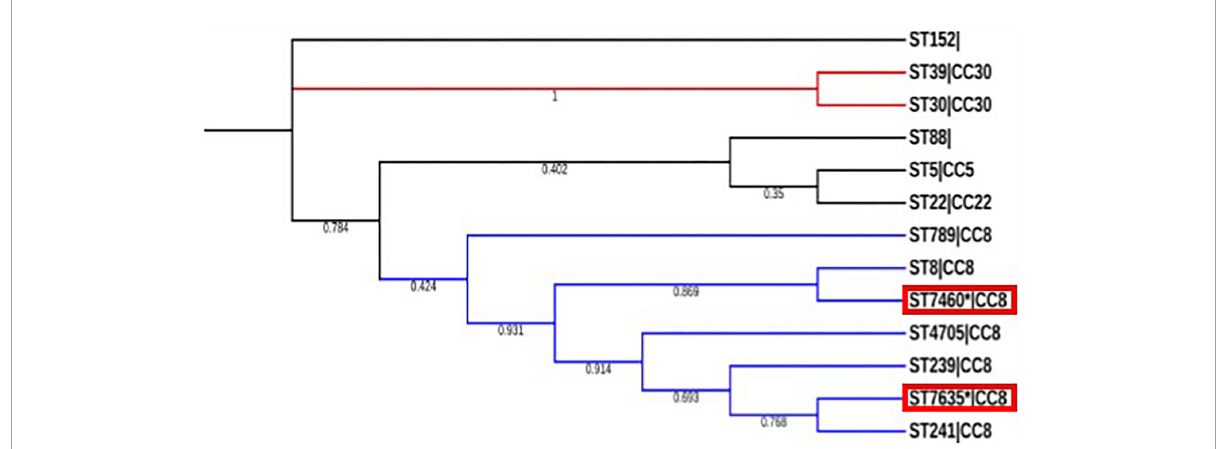
FIGURE1 Genetic relatedness of the two novel sequence types to other sequence types identified in the country. The novel sequence types (ST7460 and ST7635) are highlighted in red boxes. The tree topology was based in 1000 iterations with bootstrap support expressed as probability values. The blue branches highlighted CC8 to which ST 7460 and ST 7635